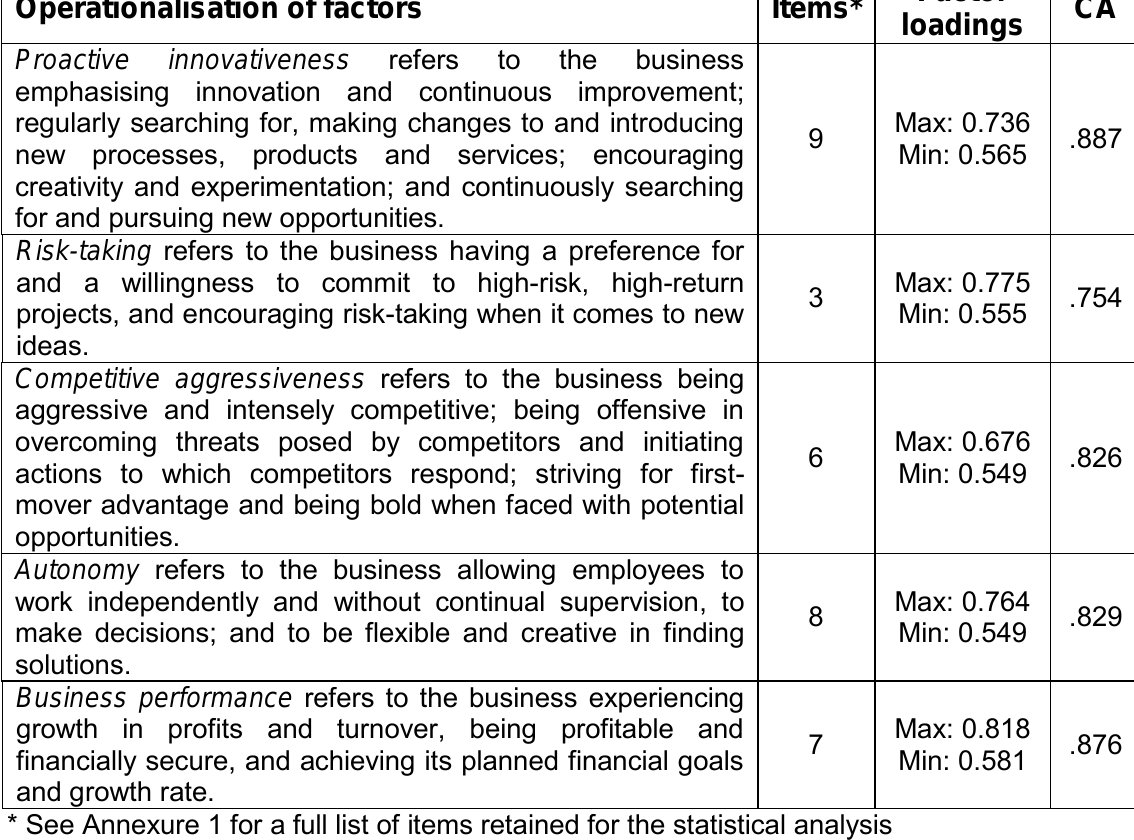
Factor CA loadings